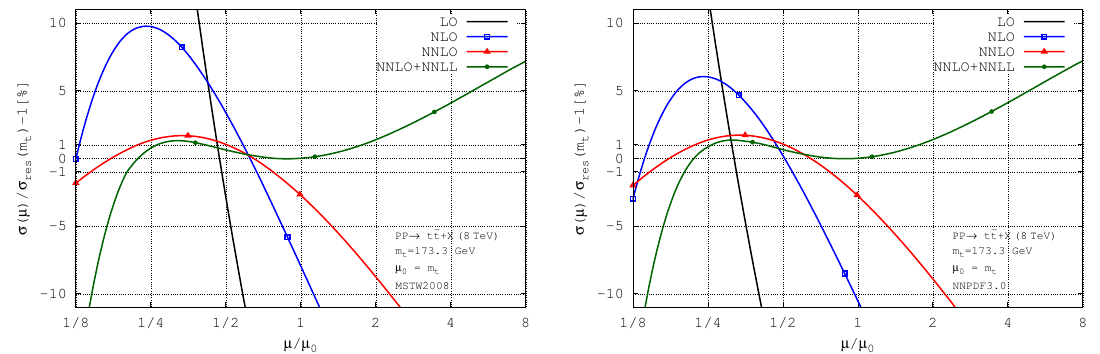
Figure 1 . Total cross-section at LO, NLO, NNLO and NNLO+NNLL QCD evaluated with a (cid:12)xed scale (cid:22) F = (cid:22) R = m t with two di(cid:11)erent pdf sets: MSTW2008 (left) and NNPDF3.0 (right). Each plot is normalised to the NNLO+NNLL cross-section evaluated with the corresponding pdf set at scale (cid:22) 0 = m t . The symbols on some of the lines are meant to help distinguish the various lines.